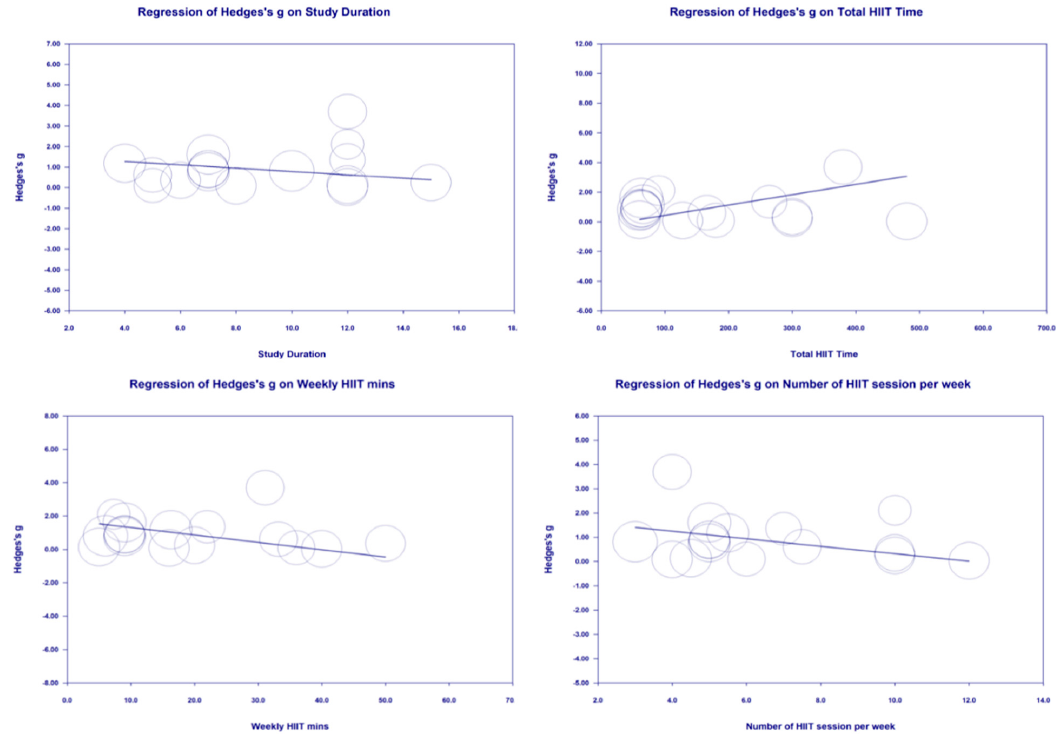
Figure 8. Moderator Analysis of the effects of study duration, total HIIT time, Weekly HIIT minutes (min) and Number of HIIT session per week on CRF.